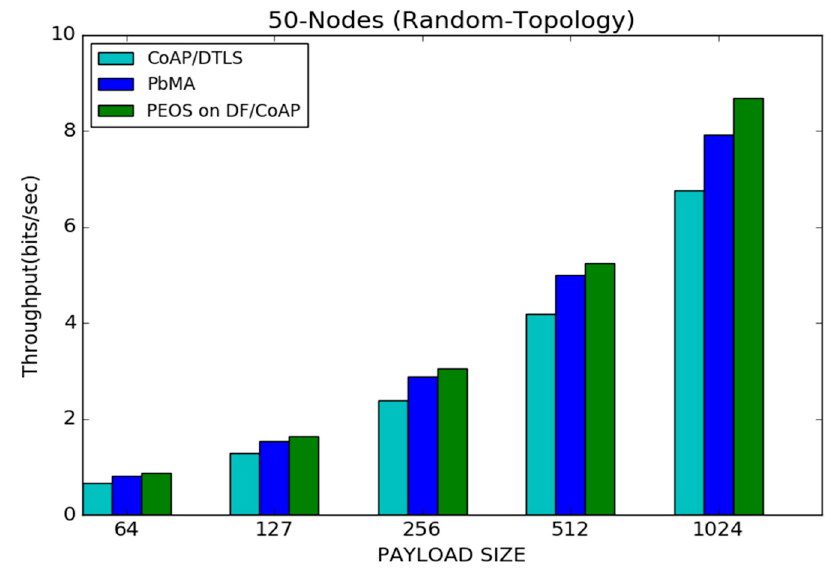
Figure 11. Payload size vs. throughput for 50 node topology.